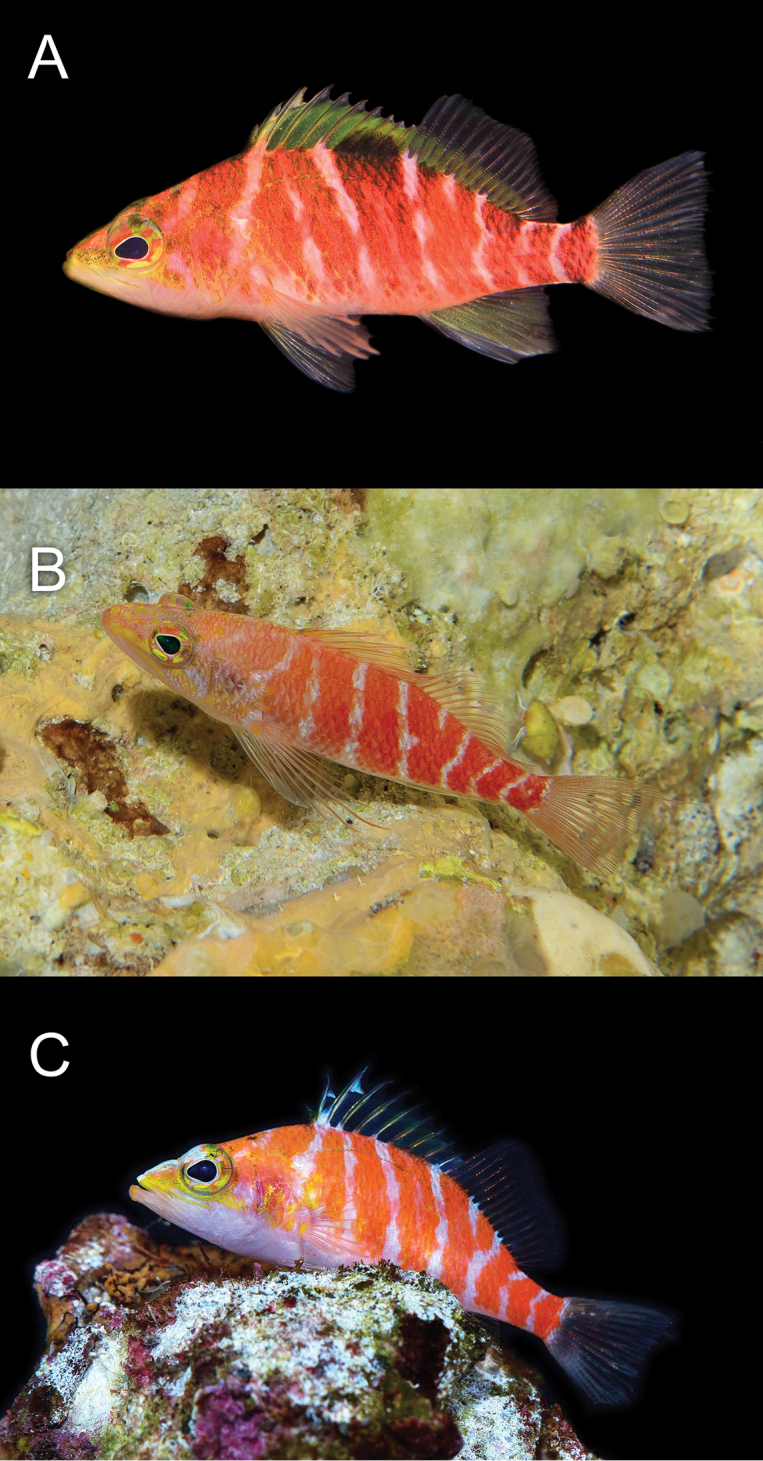
Living specimens of APlectranthias
hinano sp. nov. at Steinhart Aquarium, California Academy of Sciences BPlectranthias
cf.
bennetti photographed at a depth of 120 m at Maloelap Atoll, Republic of the Marshall Islands, and CPlectranthias
bennetti photographed in an aquarium. Photographs by T Wong (A), LA Rocha (B), and YK Tea (C).